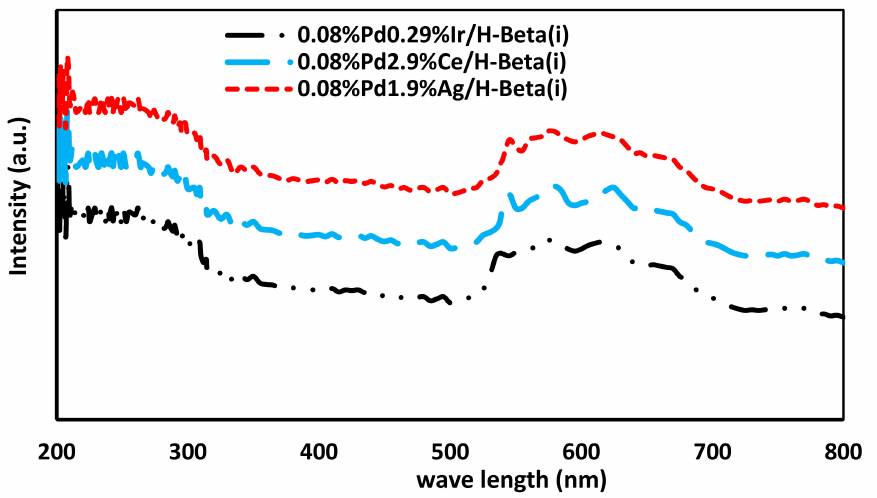
Figure 8. UV–Visible diffuse reflectance spectroscopy (UV–Vis. DRS) spectra of different